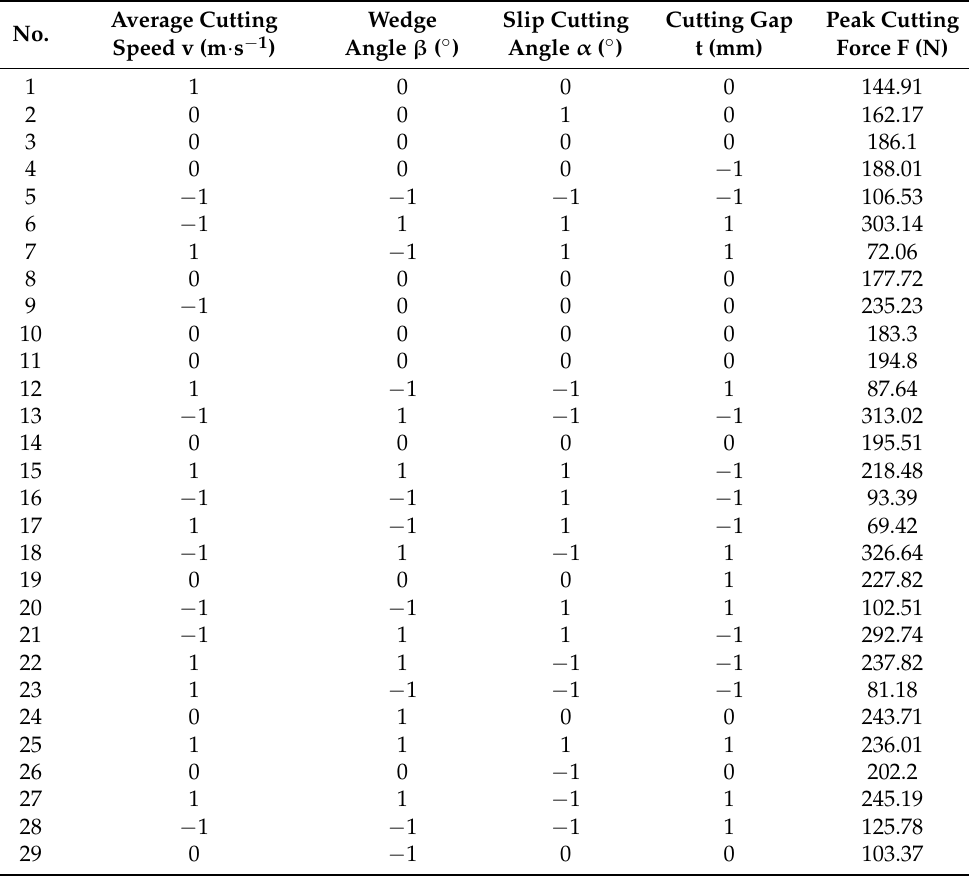
Table 6. Supported Cutting Test Design Scheme and Response